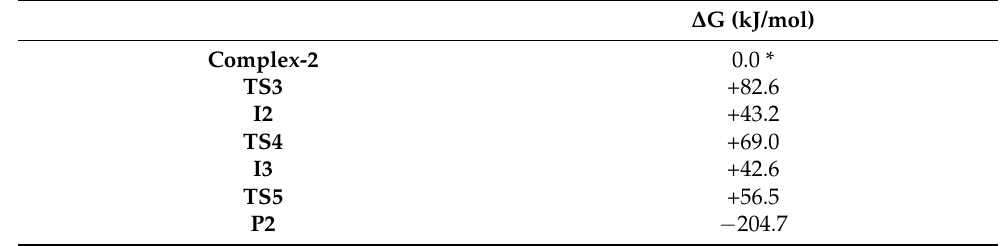
Figure 2. Comparative calculated reaction energy profile between the first (blue) and the second model (black) using a dicopper-boron borylation adduct on the non-substituted aziridine (the ∆ G values are in kJ/mol). Table 4. Free energies of the second model calculation on the non-substituted N -(2-piconiloyl) aziridine, Figure 2